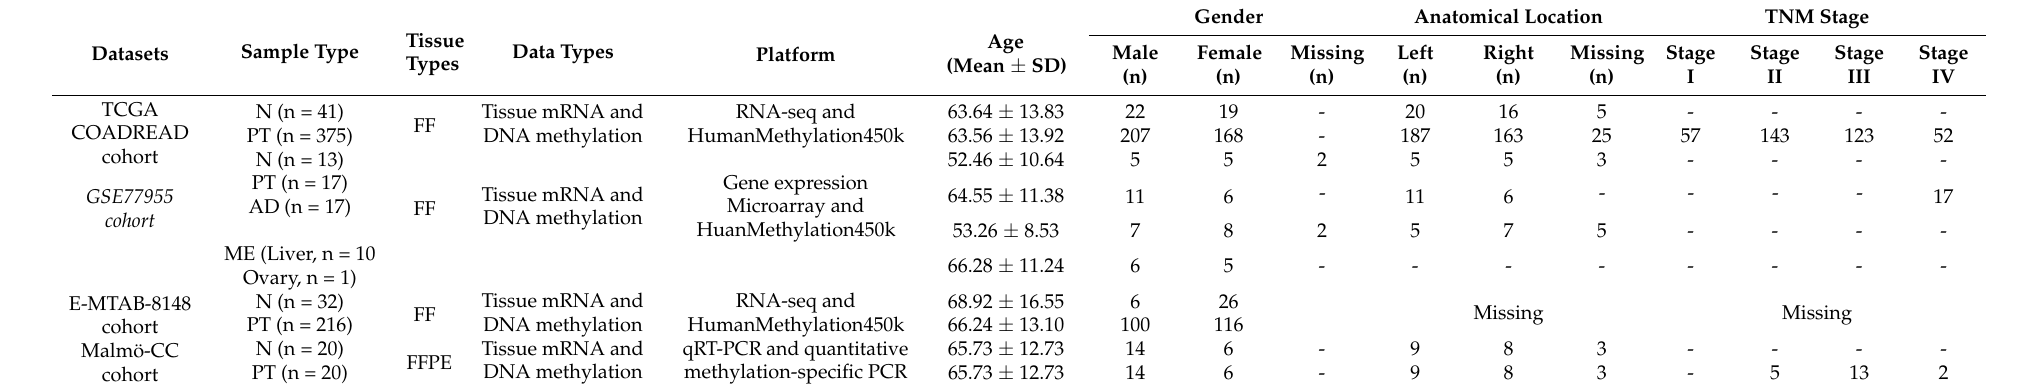
Table 1. Distribution of clinical and pathological covariates of in silico and clinical datasets. N—matched normal; AD—adenoma; PT—primary tumor;